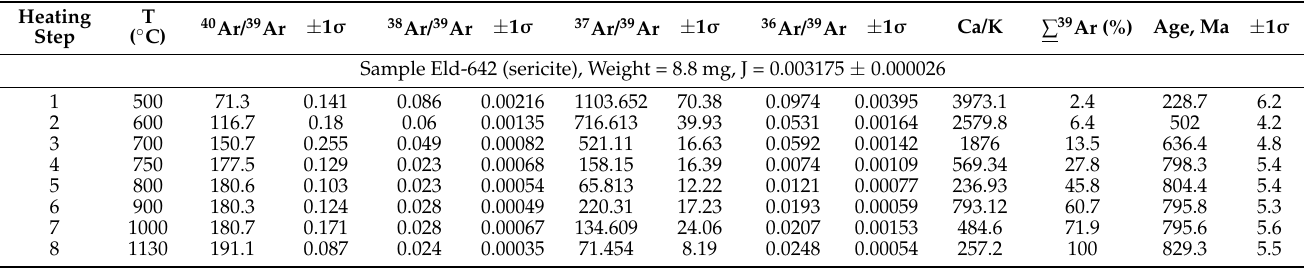
Figure 8. Distribution histograms of temperatures estimated with carbonaceous material thermometry [3]. Black peaks show distribution of temperatures obtained with Grt-Bt thermometry for the same samples (uncertainty of geothemometer is not considered). ( a – c )—Olympiada deposit: ( a )—oc-24, ( b )—oc-40, ( c )—oc-99; ( d , e )—Eldorado: ( d )—19-el-2, ( e )—19-el-5. 40 Ar/ 39 Ar dating was performed for clarification of ore processes of the Eldorado Table 5. Raman spectra position, FWHM and estimated temperature. deposit. For dating a sample of quartz vein with fragments of host garnet-biotite schists was taken. Quartz veins in garnet-biotite schists do not cross schistosity of host rocks and contain its lens-shaped fragments, mean while they are deformed conformal to host schists and often form lenses in it (Figure 9a). No retrograde changes like secondary chlorite were noticed (Figure 9b). Quartz contains inclusions of large arsenopyrite crystals (up to 1 cm) and is cut by a light-green sericite vein, which contains arsenopyrite grains as well (Figure 9c). The concentration of gold in the sample is about 5.3 ppm. For dating of the younger age limit of the ore mineralization, the fine-grained sericite was taken. Obtained plateau includes 58.4% of the total argon and indicates the age 798.6 ± 5.3 Ma (Figure 9d, Table 6). Table 6. Ar-Ar sericite